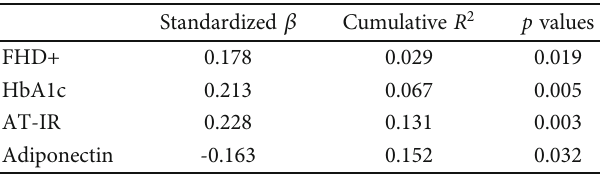
Figure 1: The scatter plot between serum orosomucoid and fasting plasma glucose (FPG), HbA1c, serum adiponectin, and adipose tissue- insulin resistance index (AT-IR). Table 2: Stepwise multiple regression analysis for serum orosomucoid as a dependent